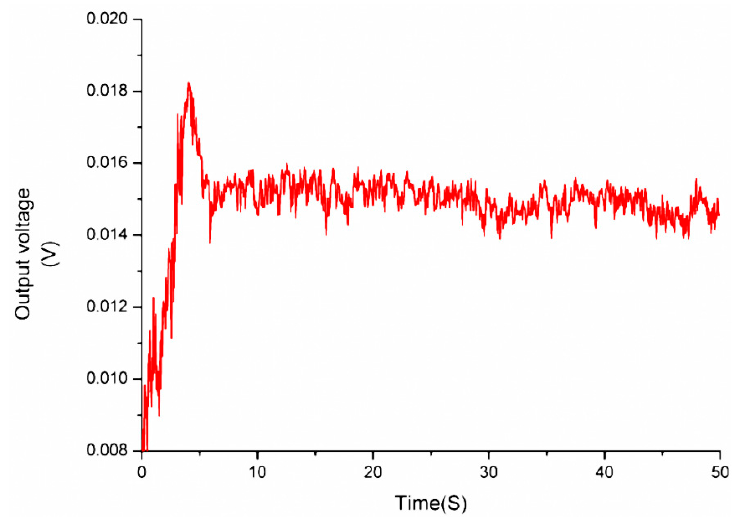
Figure 15. A measurement system for friction torque based on the force sensor.